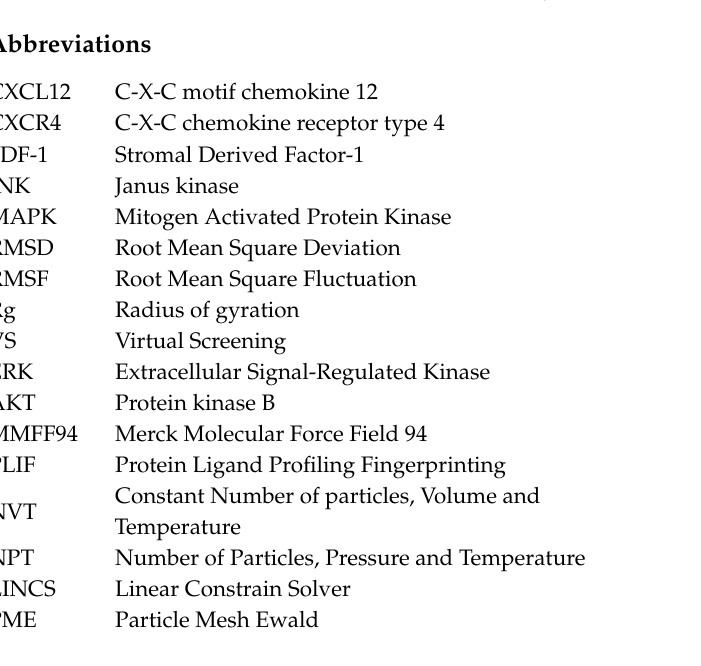
protein-ligand complexes of all screened